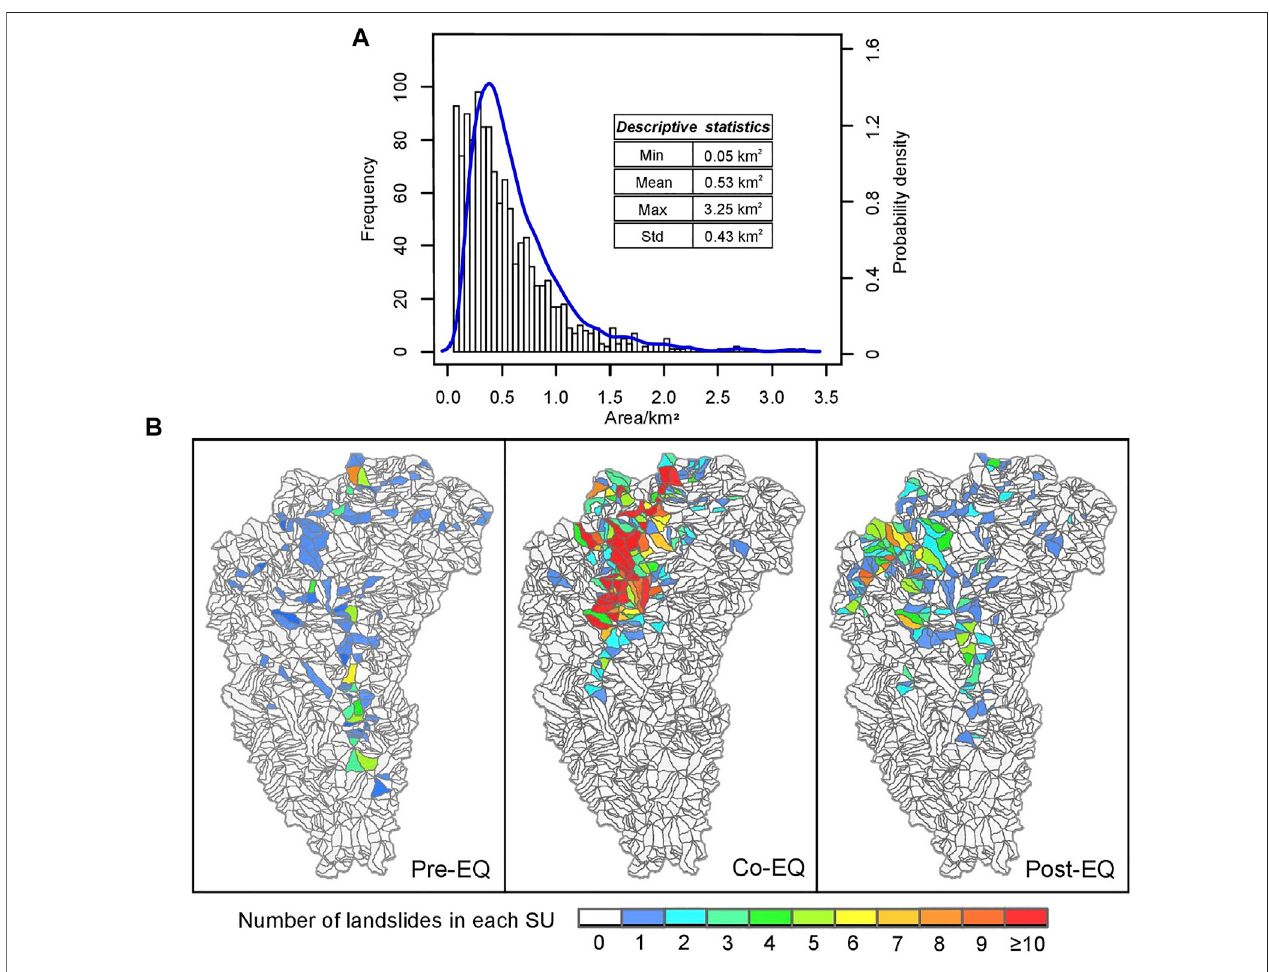
FIGURE 4 | (A) The size distribution and geometric features of partitioned 1234 SUs; (B) Delineation, landslide intensity, and the presence – absence status assignment of partitioned SUs in the study area associated with pre-, co-, and post-EQ landslides.